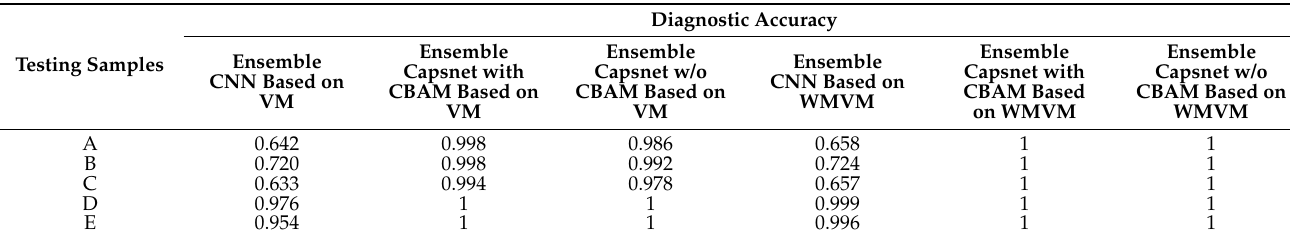
Table 6. The diagnostic accuracy of six different ensemble models for different